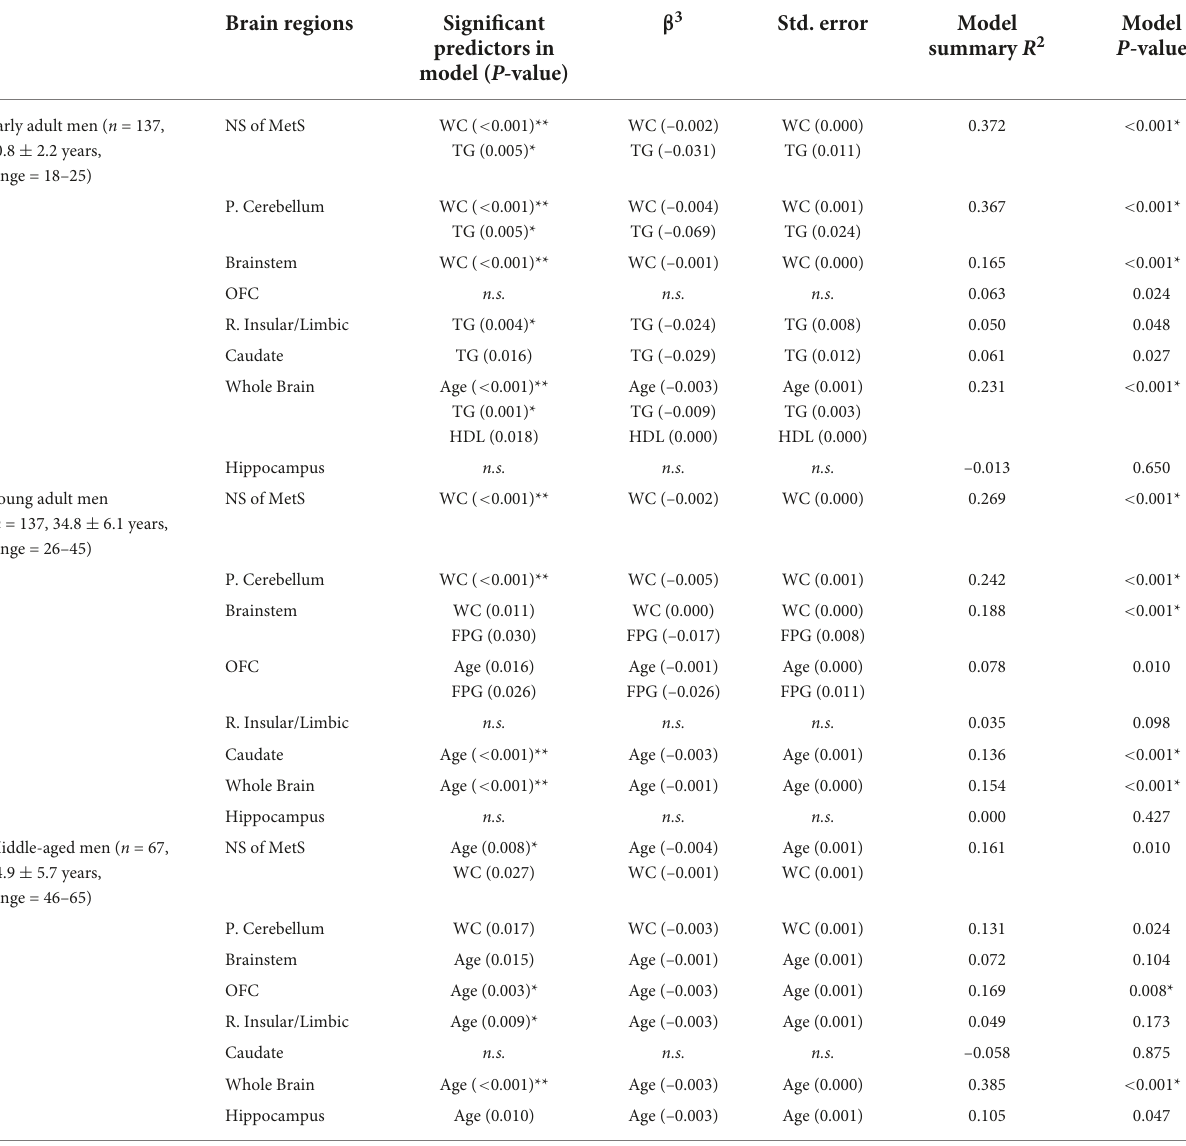
TABLE 3 MetS components’ relationship with gray matter volume in neural signature of metabolic syndrome substructures, whole brain, and hippocampus in men. Brain